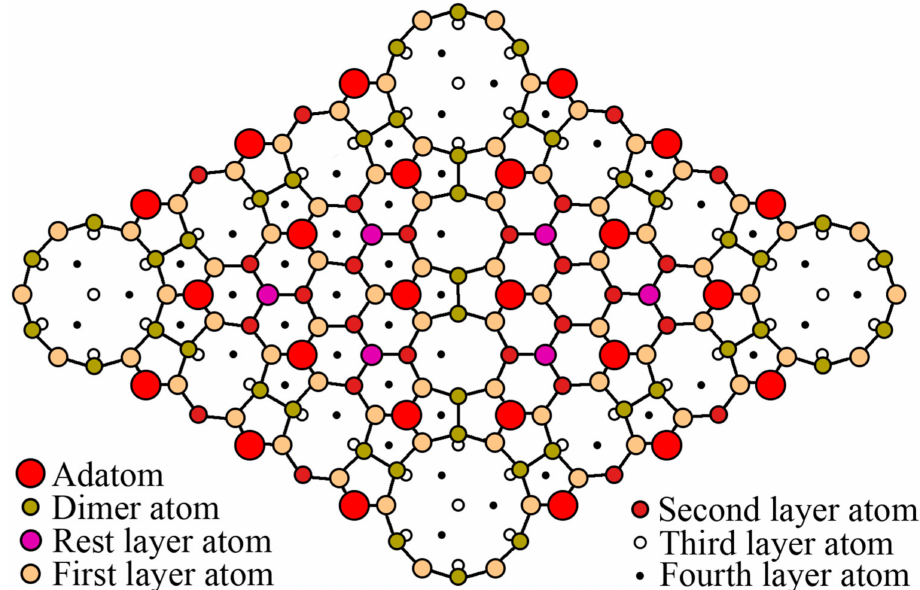
Figure 2. Schematic view of the Ge on Si(111) surface with the 7 × 7 reconstruction.